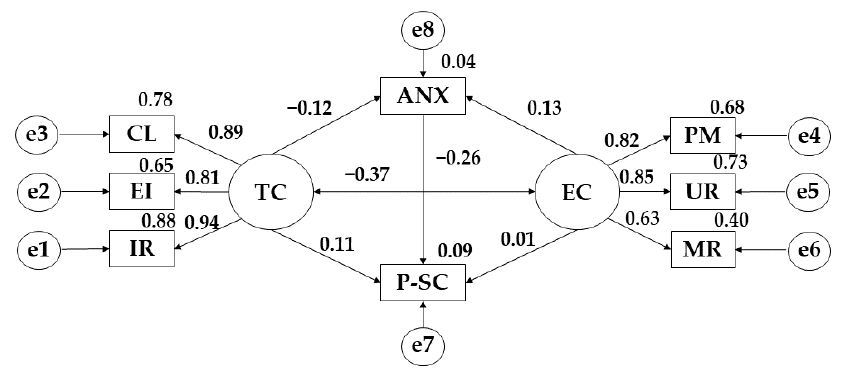
Figure 3. Model developed for medium adherence to the Mediterranean Diet. Note: Task Climate (TC); Cooperative Learning (CL); Effort/Improvement (EI); Important Role (IR); Ego Climate (EC); Punishment for Mistakes (PM); Unequal Recognition (UR); Member Rivalry (MR); Physical Self- Concept (P-SC); Anxiety (ANX).